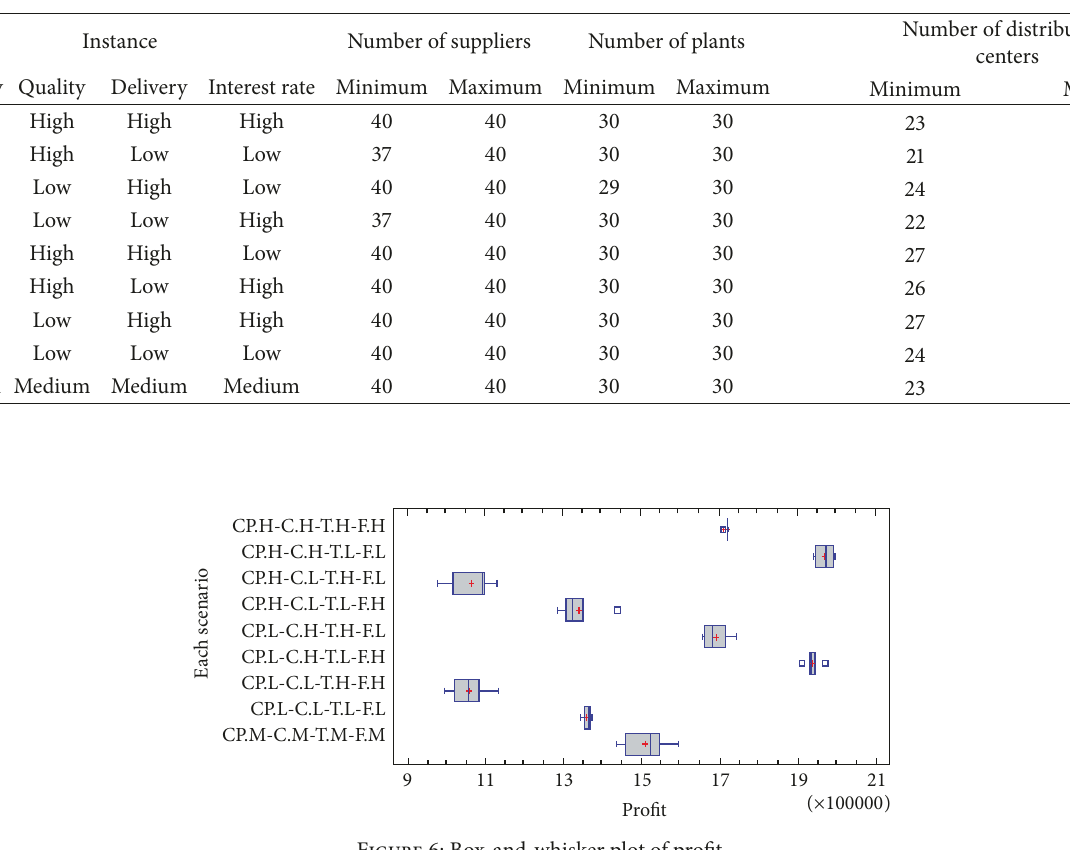
Figure 6: Box-and-whisker plot of